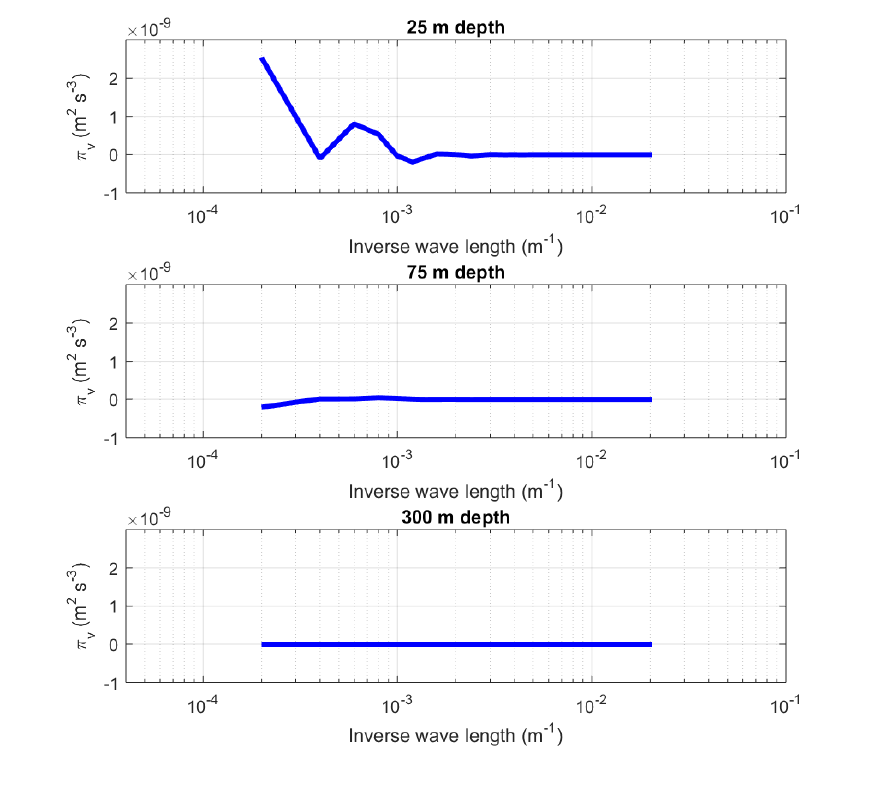
Figure 7. The kinetic energy